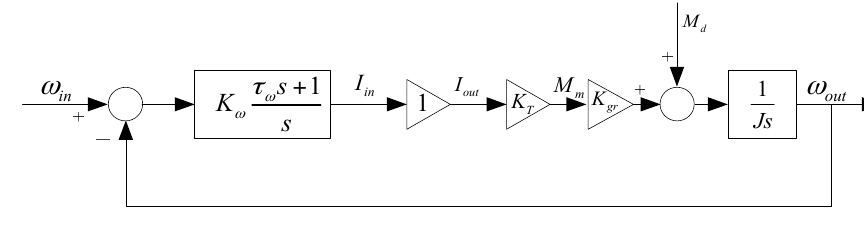
Figure 9. The structural diagram of the rate loop.